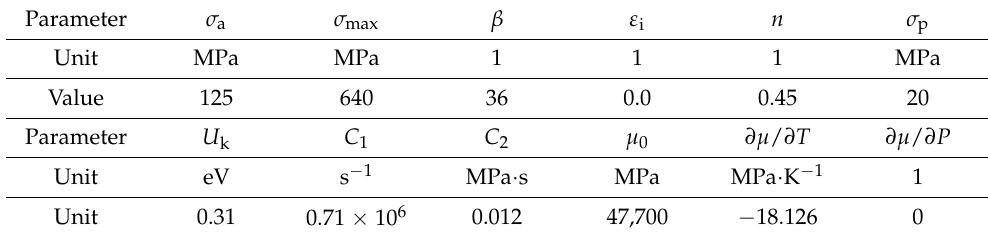
Table 11. Parameters of the SCGL model for copper [22] ( T m = 1356